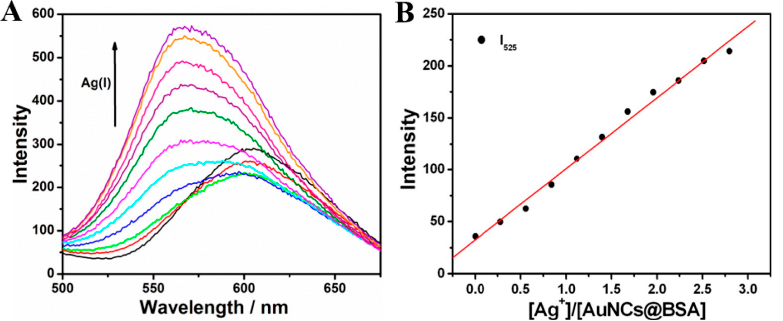
Figure 3. ( A ) Fluorescence spectra of Au 16 NCs@BSA (1 mg/mL) in buffer solution (pH 7.5) measured 20 min after the addition of AgNO 3 ( λ ex = 350 nm), from bottom to top the concentration increasing from 0 to 40.0 μ M. ( B ) Plot of photoluminescence (PL) intensity at 525 nm vs the molar ratio of Ag + to Au 16 NCs@BSA; the concentrations of Ag + are the same as in ( A ) (Copyright Ref [57], American Chemical